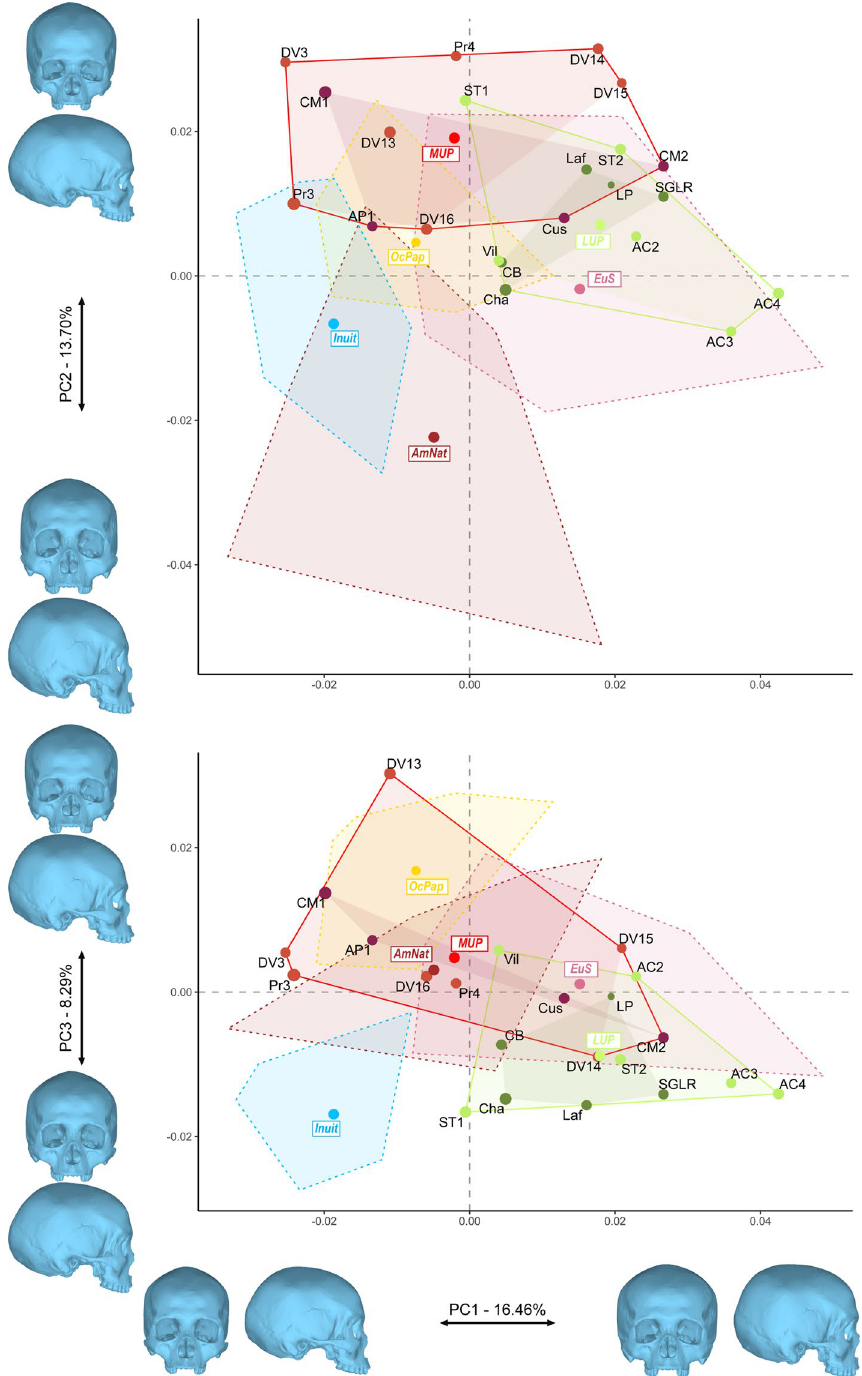
Figure 5. PC1, 2 and 3 representing 38.45% of the variation of the morphospace of the MUP, LUP and extant human samples. Convex hulls show the morphological variation of the specimens (red: MUP, MUPswf in violet and MUPmor in red; green: LUP, dark green LUPswf and light green LUPita; light blue: Inuit; yellow: Papuans; brown: Native North Americans; and pink: South Europeans). Extant modern human samples are only represented through their convex hull and the average shape of the sample. The size of the data points reflects the centroid size of the specimens and group